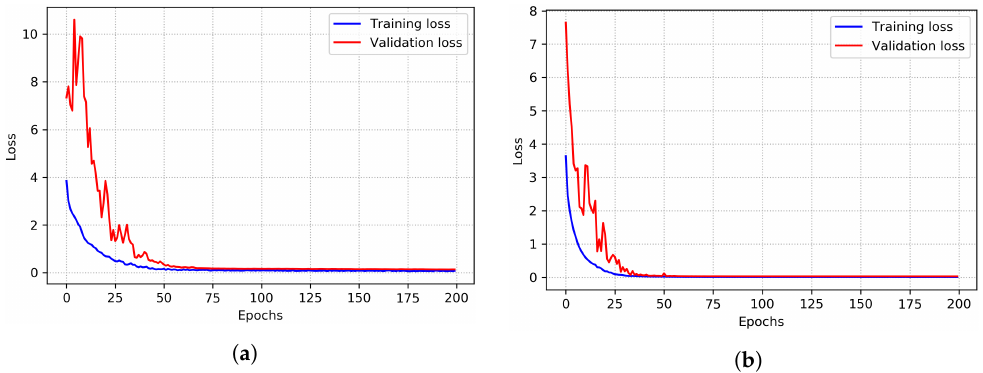
Figure 5. The average training accuracy and validation accuracy of KinectGaitNet on the UPCV and KGB datasets. ( a ) On UPCV dataset. ( b ) On KGB dataset.